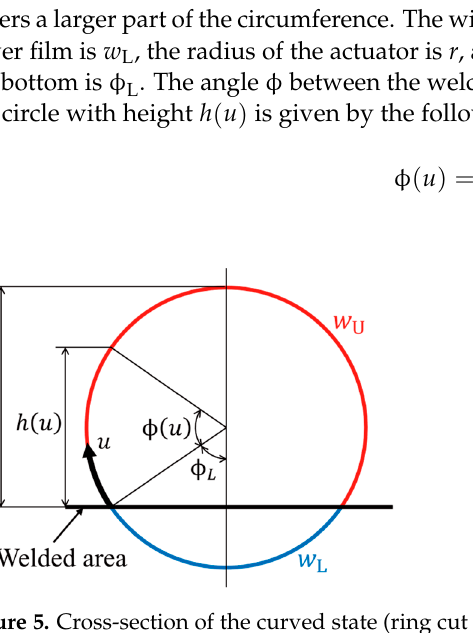
Figure 4. Side section view of the bellows structure.